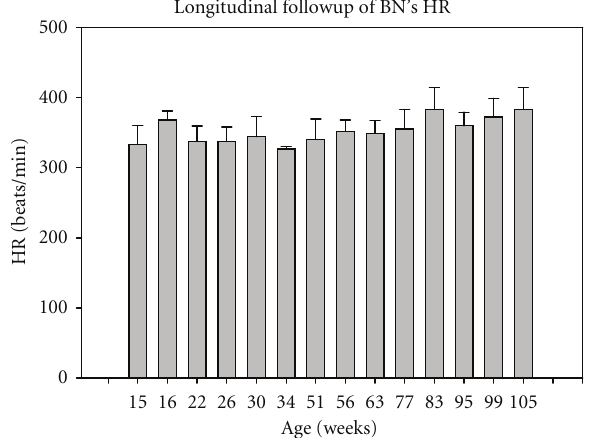
Figure 4: Follow-up of BN’s heart rate (HR) as a function of aging. No significant change in HR was observed, P = 0 . 075.